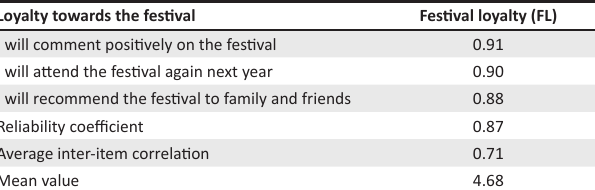
TABLE 3: Results from the factor analysis regarding visitor loyalty (dependent variable). Loyalty towards the festival Festival loyalty (FL)